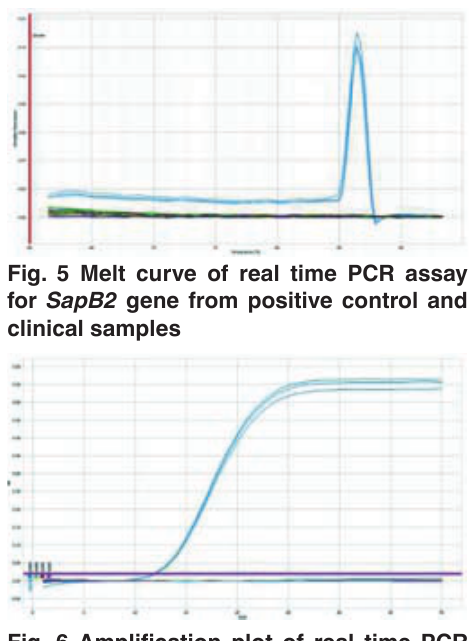
Fig. 6 Amplification plot of real time PCR assay for ISCfe-1 gene from positive control and clinical samples